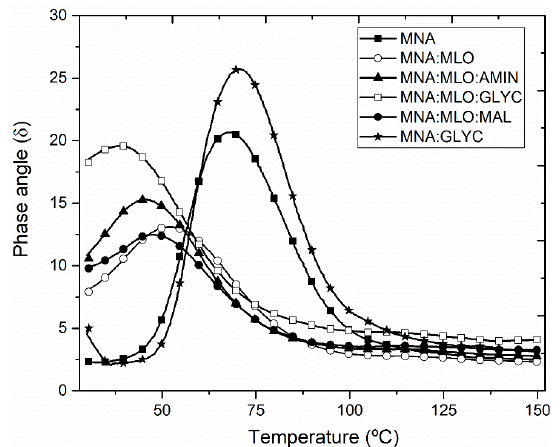
Figure 7. Comparative plot of the phase angle (δ) of different composites based on ELO epoxy resin cross-linked with MNA/MLO mixture and flax fabric reinforcement with different surface treatments.